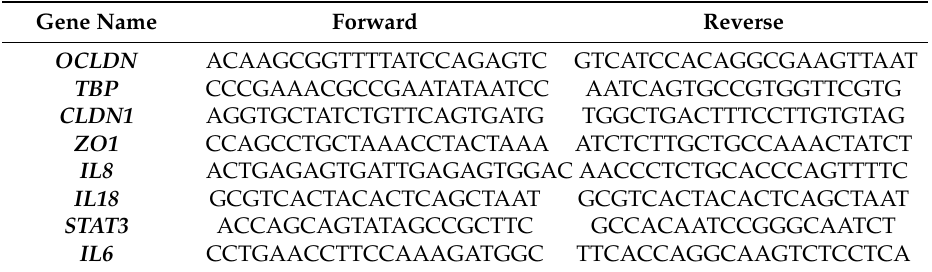
Table 1. Human primers sequences.